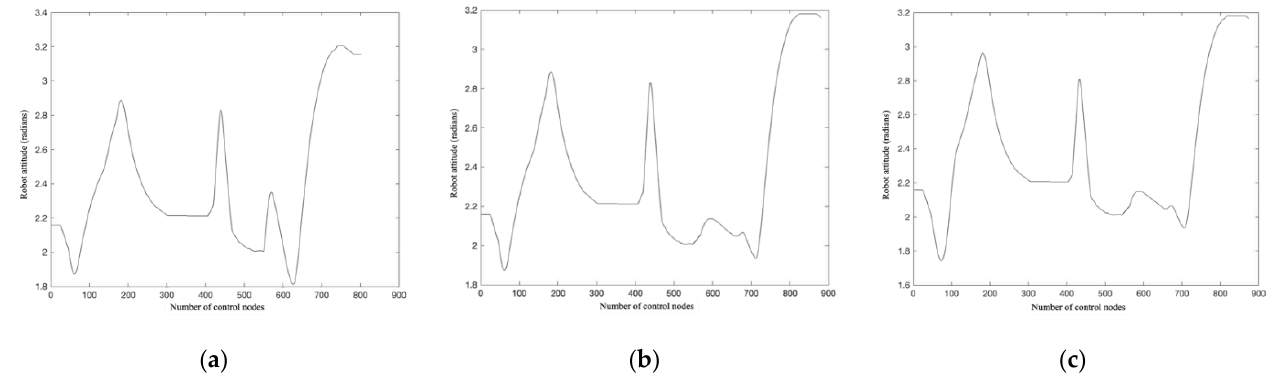
Figure 4. Path planning trajectory diagram of random obstacle avoidance: ( a ) Path planning without random obstacles; ( b ) Path planning when adding one random obstacle; ( c ) Path planning when adding two random obstacles; ( d ) Path planning when adding three random obstacles.